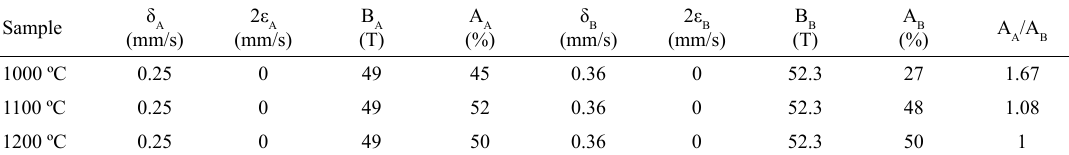
O . δ and δ are the isomer shifts, 2 2 4 A B and A are the relative spectral areas for irons at (A) and [B] sites, respectively. A B